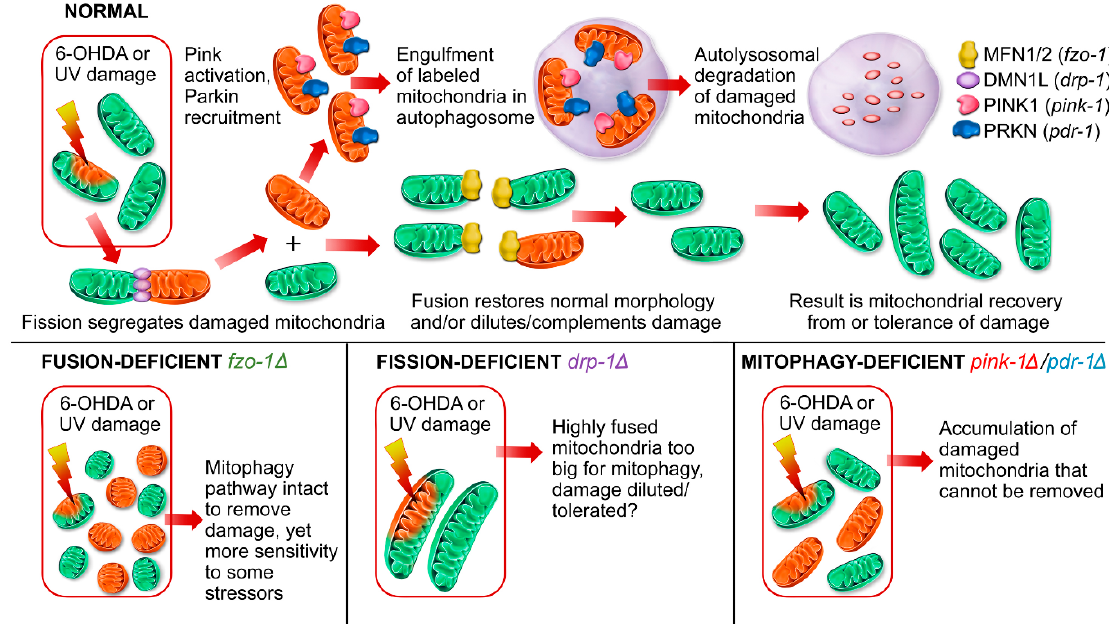
Figure 1. A role for mitochondrial dynamics in removing damage from 6-hydroxydopamine (6-OHDA) or ultraviolet C radiation (UVC) radiation. In this study, we hypothesize that genetic alterations in mitochondrial dynamics processes diminish the ability of dopaminergic neurons to respond to mitochondrial damage caused by UVC radiation or 6-OHDA exposure. Orange mitochondria represent damaged organelles, while green mitochondria are undamaged. The protein legend in the top right of the figure provides the human protein names (e.g., MFN1 / 2) with the corresponding Caenorhabditis elegans homolog (e.g., fzo-1 ) in parentheses. Genetic mutations (indicated by a ∆ symbol) in this figure are also depicted using the same colors in Figures 2–5.